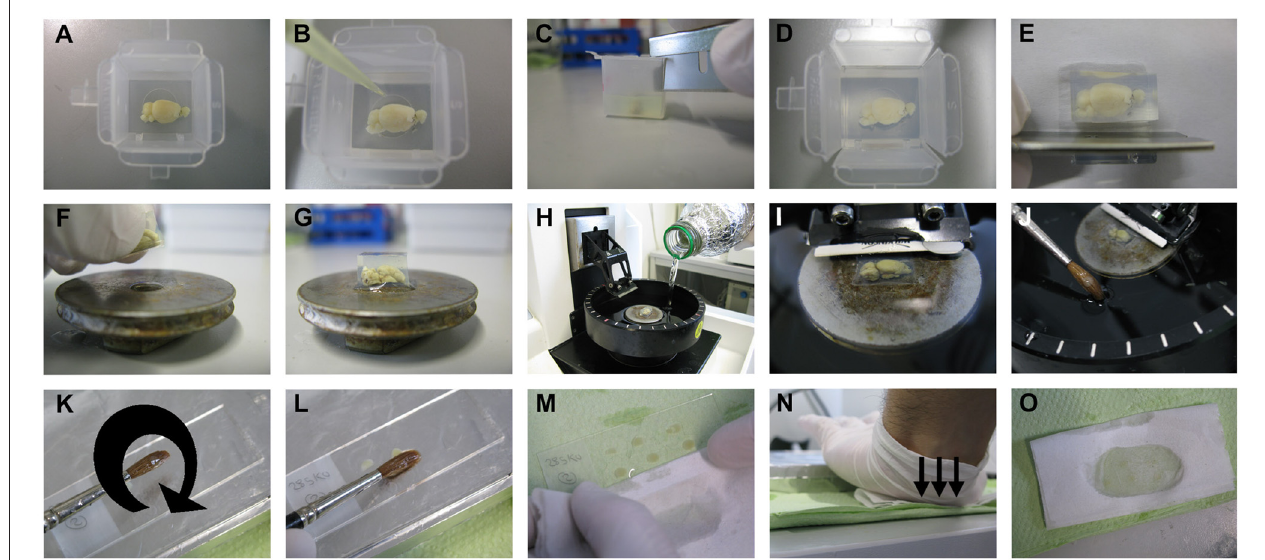
FIGURE 3 | Sectioning step . The brain sample is embedded in 4% low melting point agarose. After pouring the agarose solution on the brain and thus into the embedding mold, the position of the brain needs to be adjusted by keeping the cut side to the bottom of the mold using a pipette tip (A,B) . After complete hardening of the agarose, the mold is cut at the edges, then at the sides, and the surplus agarose around the sample is further trimmed with a razor blade (C–E) . The trimmed agarose block is fixed to a vibratome plate (F,G) , and the plate is placed into the vibratome chamber, which is subsequently filled with tissue-protectant solution just until the agarose block is well covered (H,I) . Using a thick brush, sections are collected from the vibratome chamber and transferred onto gelatin-coated slides (J–L) . The surplus tissue-protectant solution around the sections is cleaned off with tissue paper, and the sections are blotted onto the slides by applying direct, downward moderate pressure with the heel of the palm (M–O) .